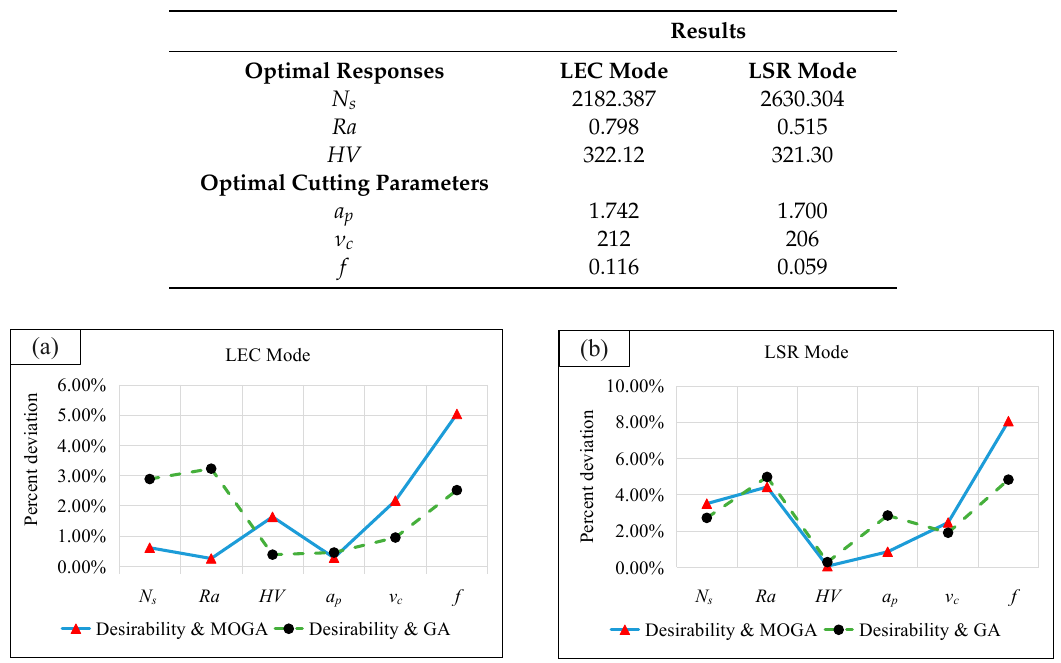
Table 13. Optimization results through GA.